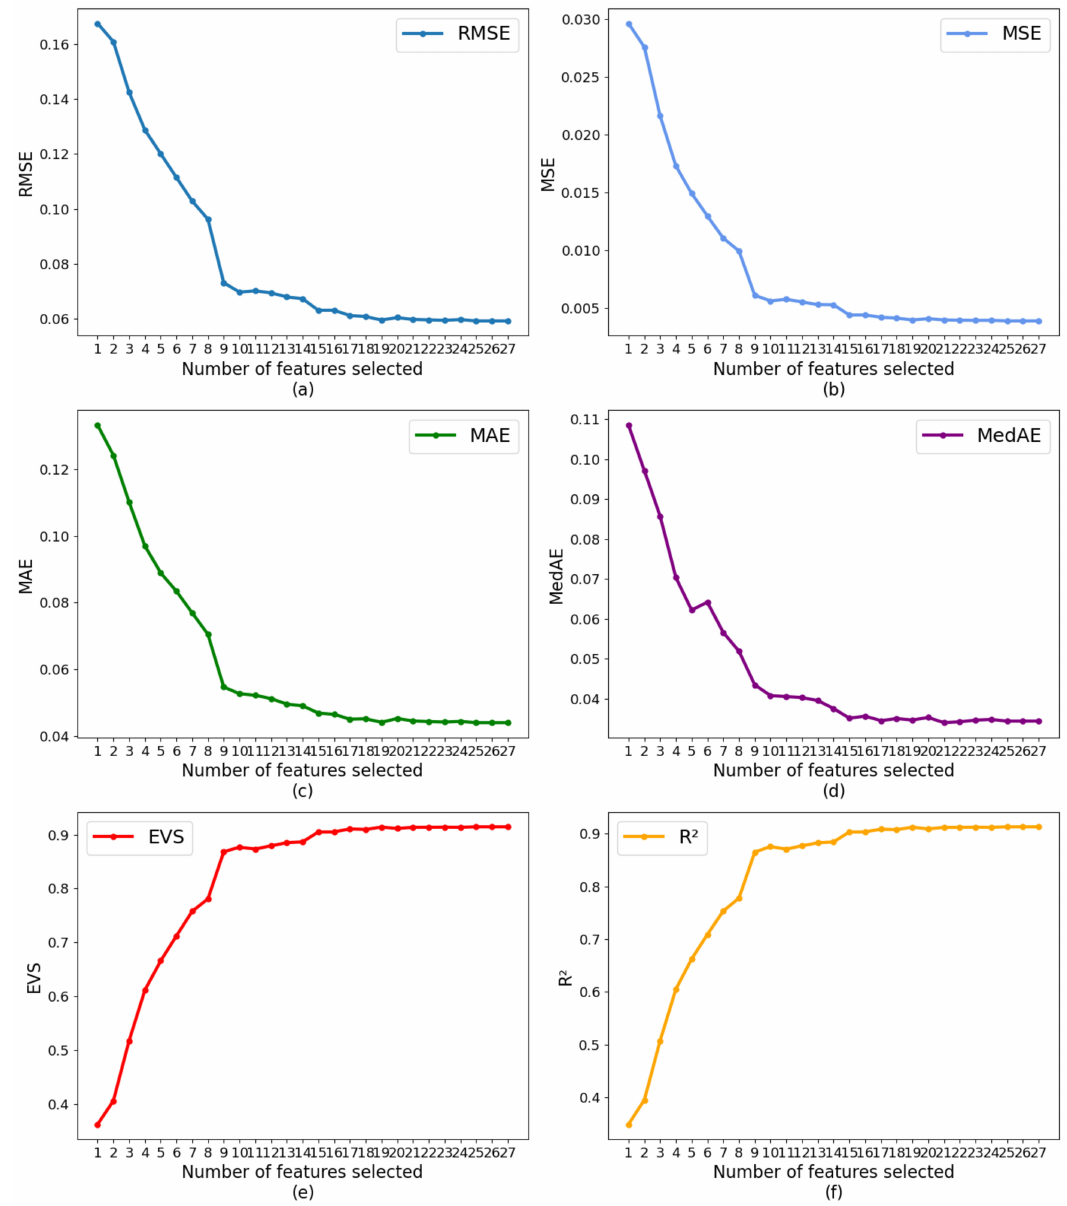
Figure 11. RFECV results under different evaluation criteria: ( a ) RMSE; ( b ) MSE; ( c ) MAE; ( d ) MedAE; ( e ) EVS; ( f ) R 2